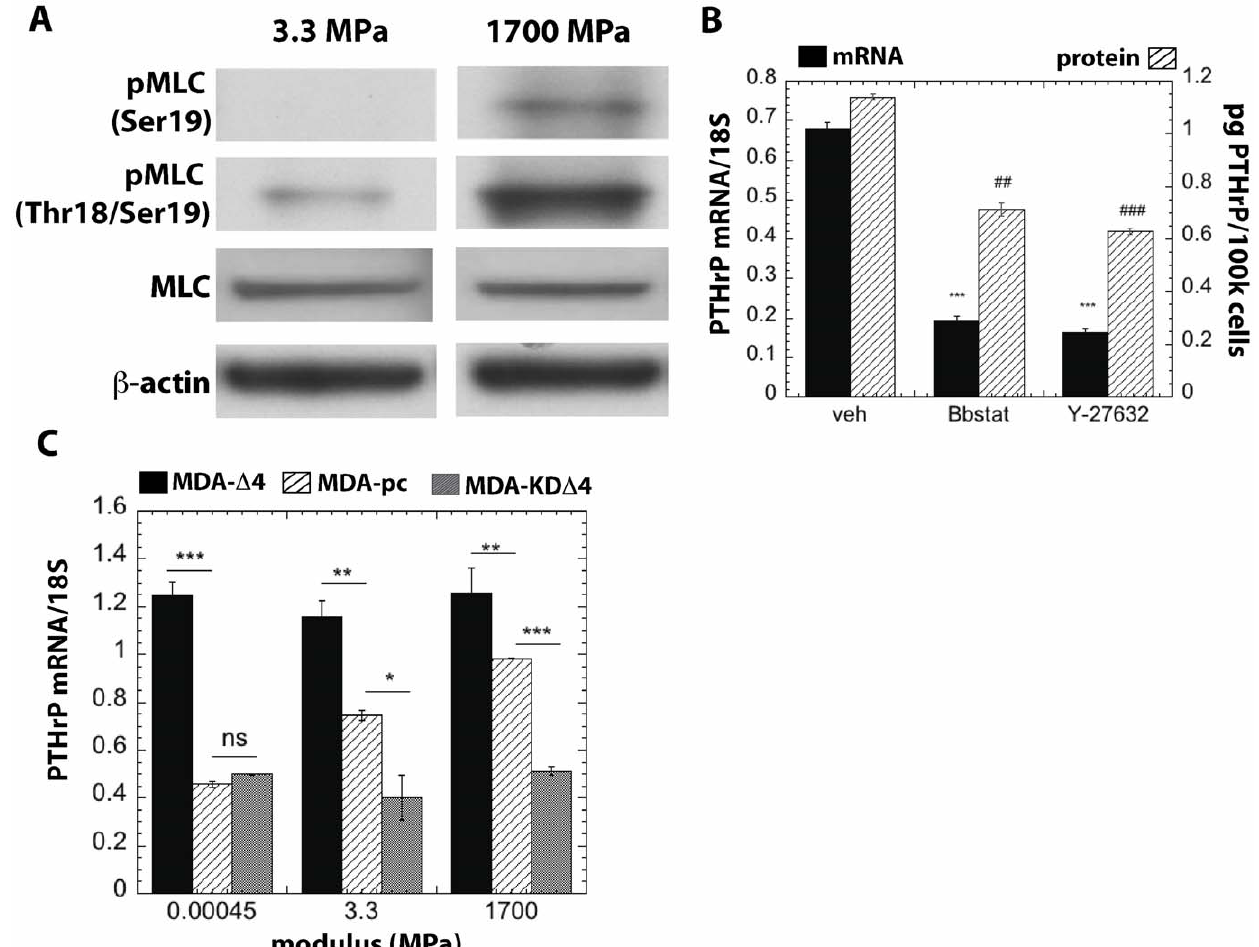
Figure 4. Mechanotransduction signals are regulated by values of the substrate modulus in the MPa range. (A) Western blot analysis of myosin light chain phosphorylation shows higher pMLC expression by MDA-MB-231 cells seeded on more rigid (1700 MPa) relative to softer (3.3 MPa) PUR substrates. (B) Pharmacological inhibition of actomyosin contractility (blebbistatin) and ROCK (Y-27632) decreases PTHrP gene expression and protein secretion in MDA-MB-231 cells. Similar patterns were observed for RWGT2 cells (data not shown). The optimal doses of blebbistatin and Y-27632 were identified to be 50 uM and 20 uM, respectively through dose-response experiments (data not shown). (C) PTHrP is over-expressed and does not increase with rigidity in MDA-MB-231 cells genetically modified to express a constitutively active form of ROCK (MDA- D 4 cells). Similarly, PTHrP expression does not increase with rigidity in MDA-MB-231 cells genetically modified to express a dominant negative form of ROCK (MDA-KD D 4 cells). MDA cells transfected with a plasmid control (MDA-pc) show significant increases in PTHrP expression with rigidity. *, # =p , 0.05; **, ## =p , 0.01; ***, ### =p , 0.005. doi:10.1371/journal.pone.0015451.g004 PLoS ONE |